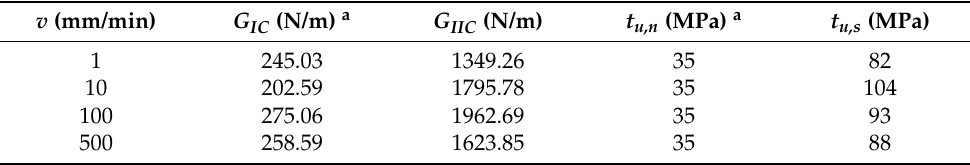
Table 4. Interface strength values used for different displacement rate